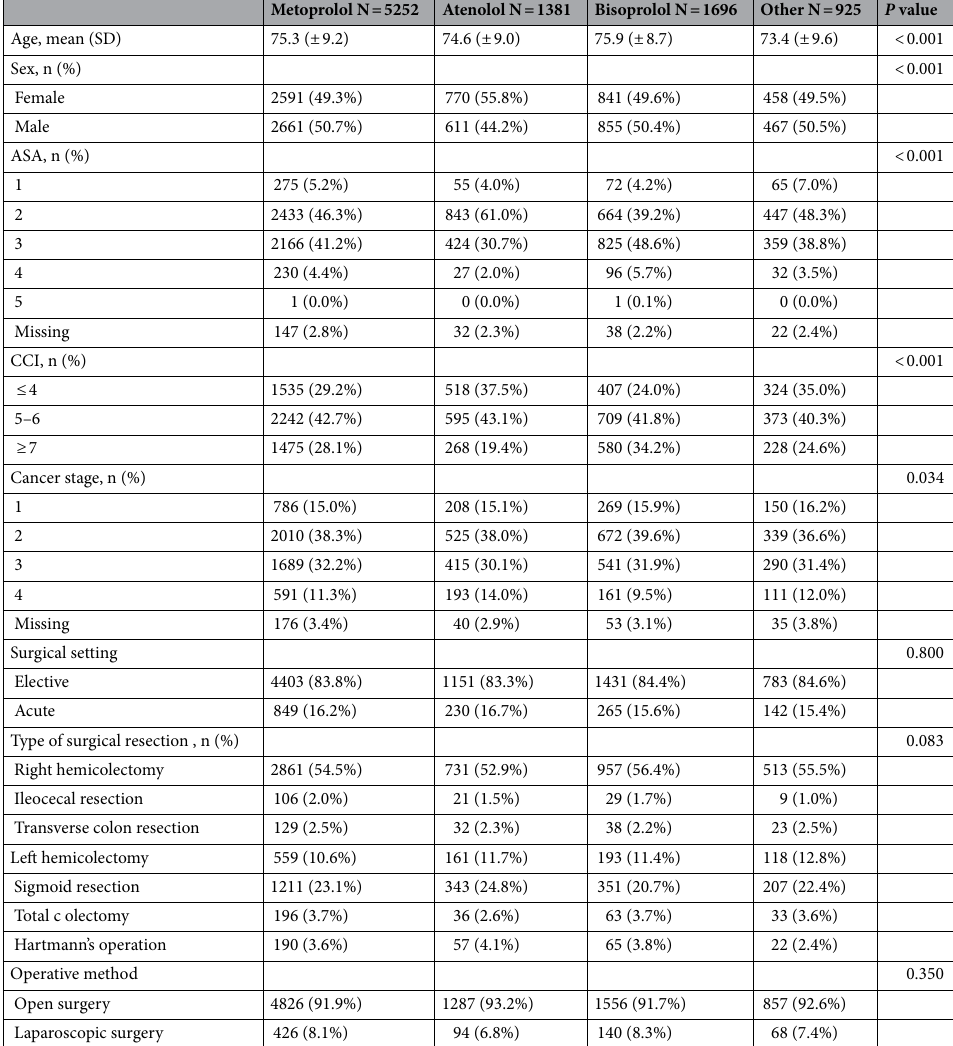
Table 1. Patient demographics. N, Total number of patients; ASA, American Society of Anesthesiologists; CCI, Charlson Comorbidity Index.